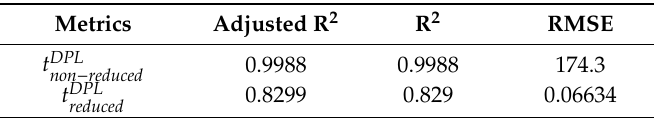
Table 2. Simulation time approximation.